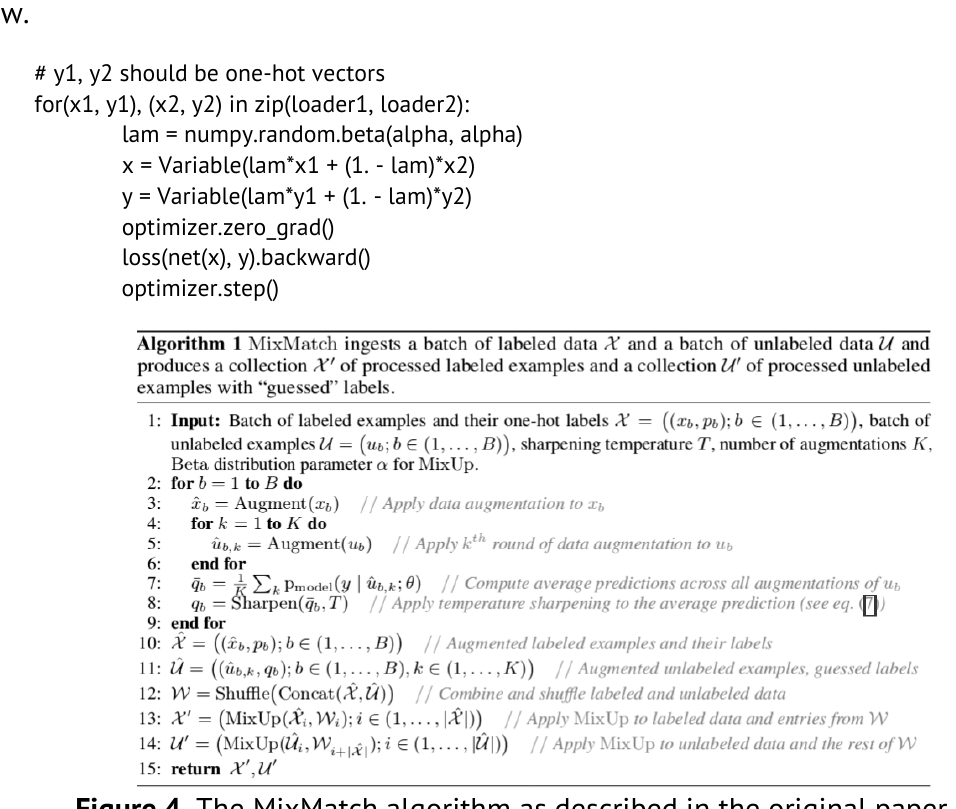
Figure 4. The MixMatch algorithm as described in the original paper